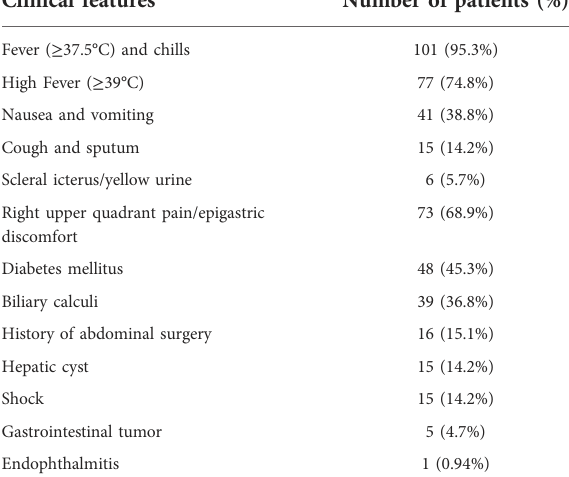
TABLE 2 Laboratory features of